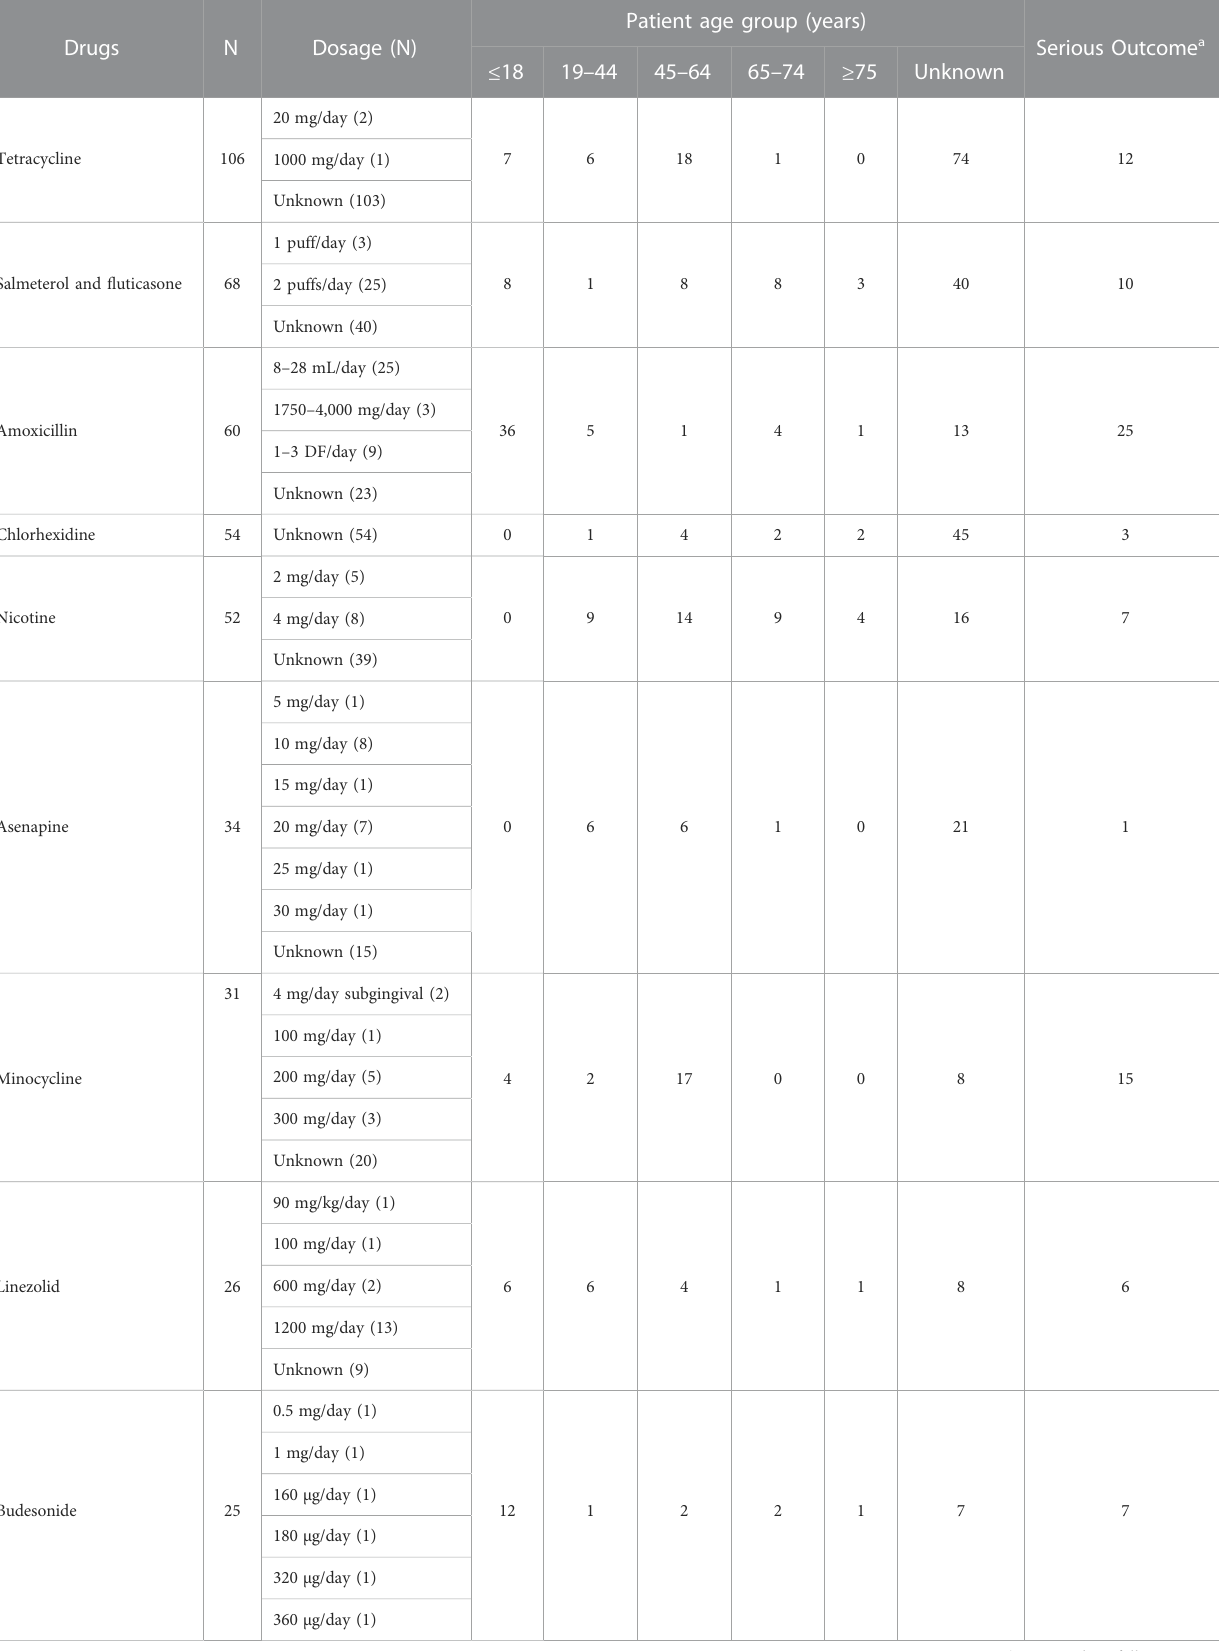
TABLE 4 The characteristics of AE reports involving drugs with positive risk signals of tooth